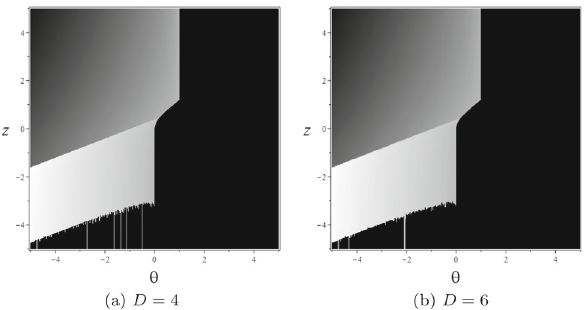
Fig. 3 A density plot of the numerical values of the scalar field’s pro- file in the inside of the horizon (for an exemplifying fixed r < r h ) is displayed.Thecompletelyblackpatchesdepictregionsintheparameter space where the field takes complex or unbounded (divergent) values. We show the D = 4 , 6 cases from left to right for